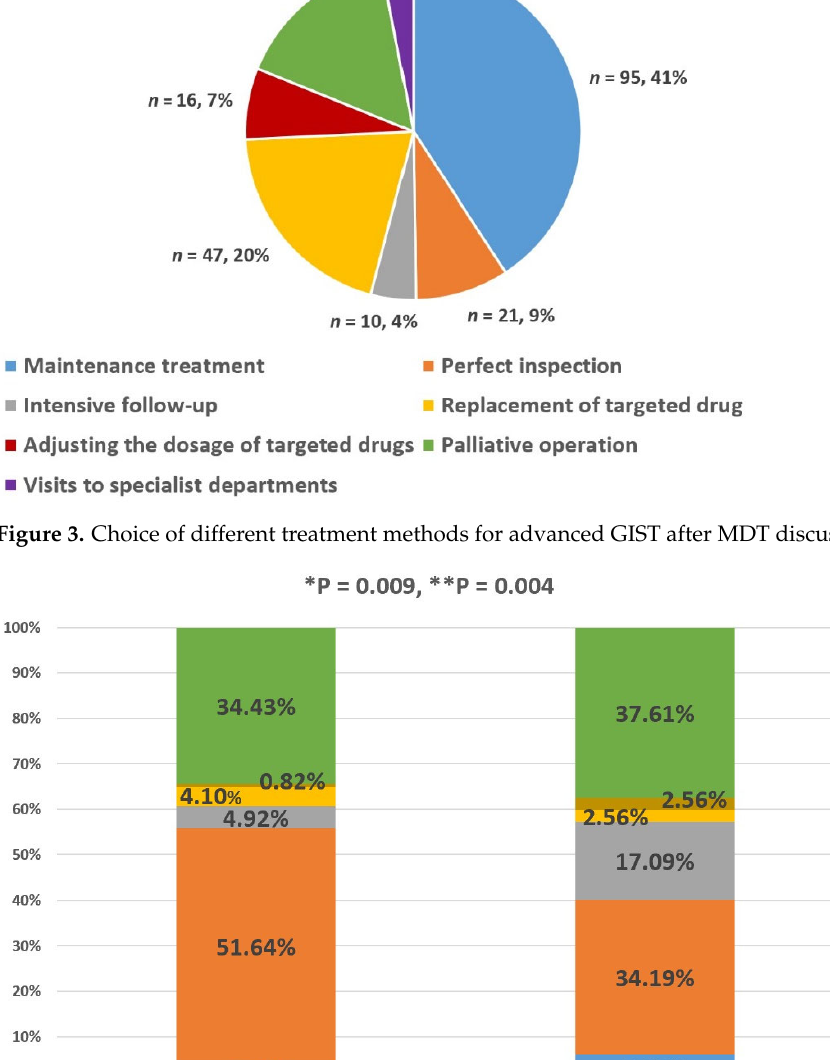
Figure 3. Choice of different treatment methods for advanced GIST after MDT discussion.